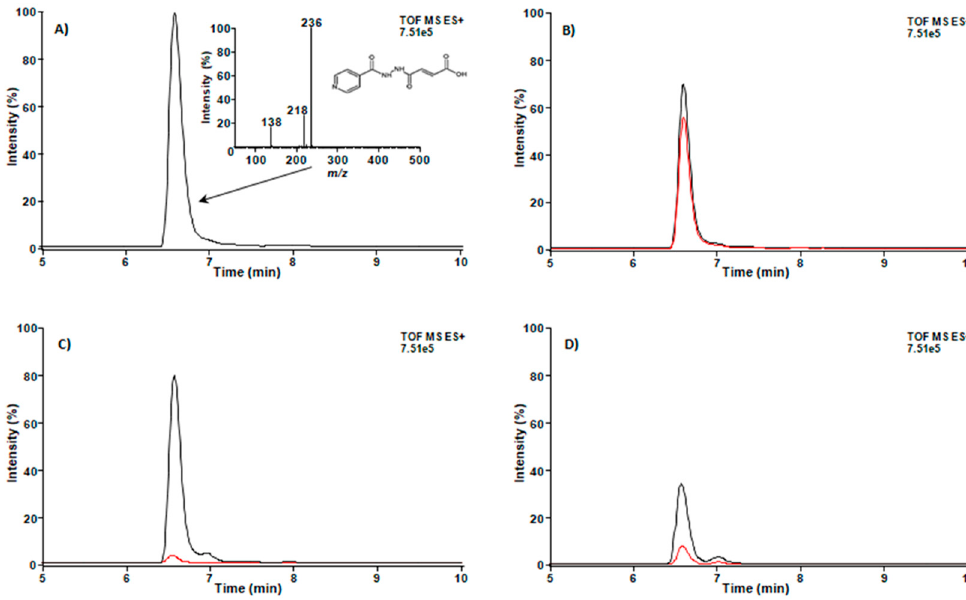
Figure 4. Detection of IN14 by LC-MS. ( A ) IN14 chromatogram and electrospray ionization (ESI) ( + ) mass spectrum. Extracted ion chromatograms (EIC) of m / z = 236 in samples of cerebrospinal fluid ( B ), plasma ( C ), and urine ( D ). Mice ( n = 5) were treated with IN14 for one day (red line) and five days (black line), fluid extraction and LC-MS analysis are described in the Materials and Methods section.